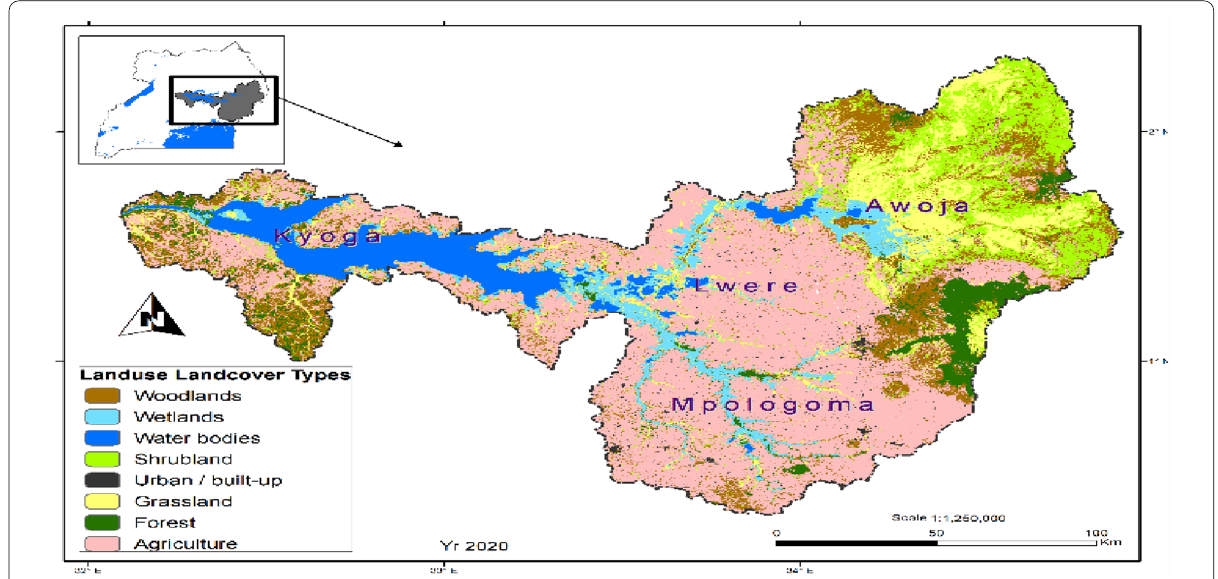
Fig. 2 The current LULC map of the study area ( Source: Obubu et al.